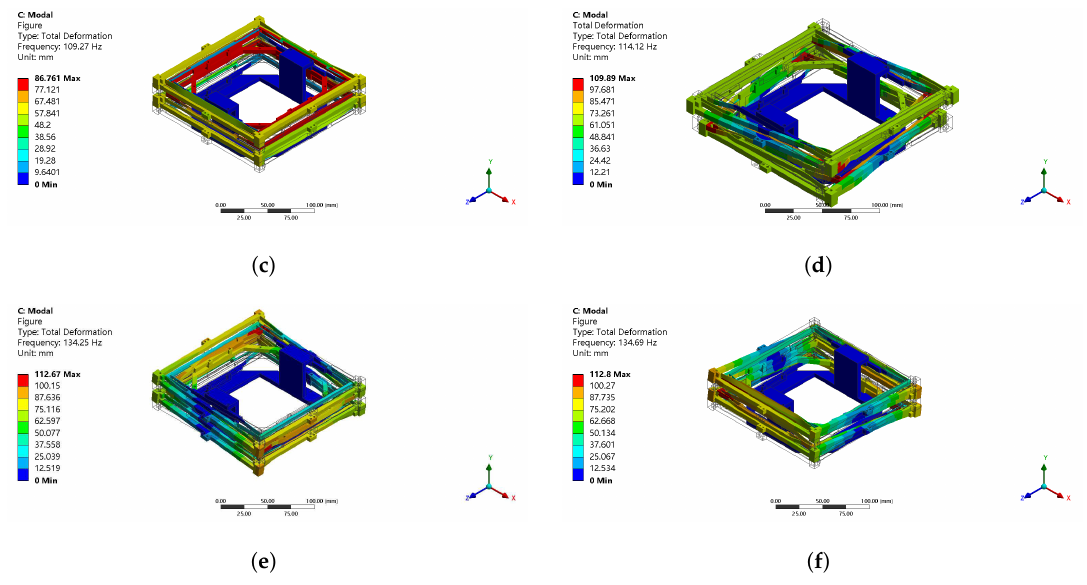
Figure 9. ( a ) 1st, ( b ) 2nd, ( c ) 3rd, ( d ) 4th, ( e ) 5th, and ( f ) 6th modes of resonant frequencies obtained by finite-element